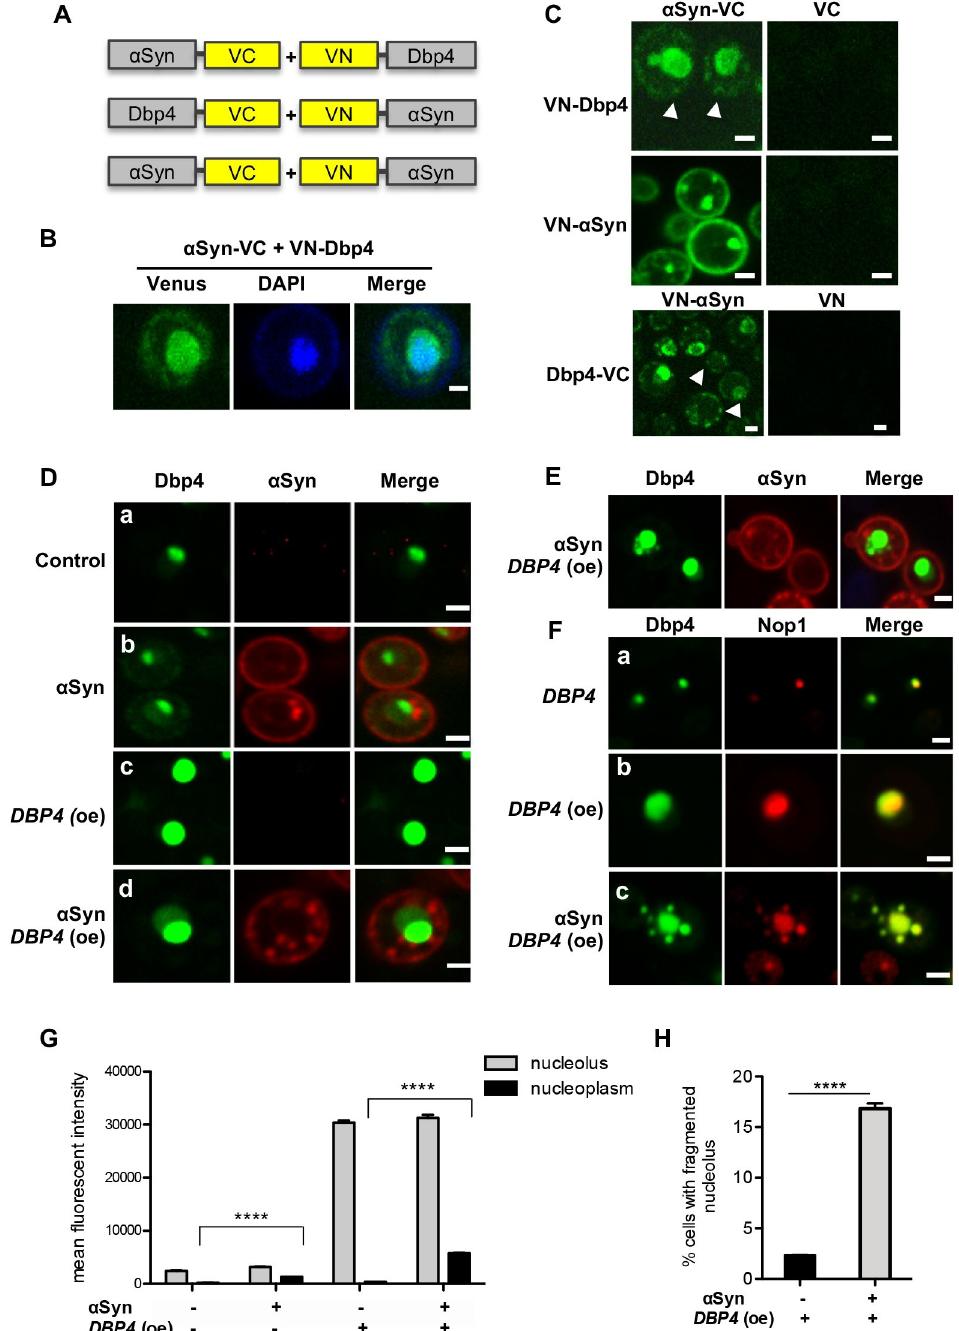
Fig 5. Dbp4 physically interacts with α Syn. (A) Schematic representation of Bimolecular Fluorescence Complementation assay (BiFC) constructs. Dbp4 and α Syn were fused to the non-fluorescent complementary N- and C-terminal fragments of fluorescent Venus reporter protein (VN and VC) in two different fusion protein combinations. ( B) Live-cell fluorescence microscopy of yeast W303 cells expressing VN-Dbp4 and α Syn-VC constructs with DAPI stained nucleus. Scale bar = 1 μ m (C) BiFC with different combinations of the fusion constructs. VN- α Syn + α Syn-VC served as positive and BiFC with VC or VN as negative controls. The image display is scaled to the minimum and maximum pixel intensity values per image for optimal noise-to signal ratios. Scale bar = 1 μ m. White arrow heads indicate cytoplasmic foci. (D) Fluorescence microscopy of cells expressing DBP4 -GFP from its native promoter with empty vector as a control (a) or α Syn-mCherry (b). Overexpression of DBP4 -GFP from 2 μ vector with empty vector as